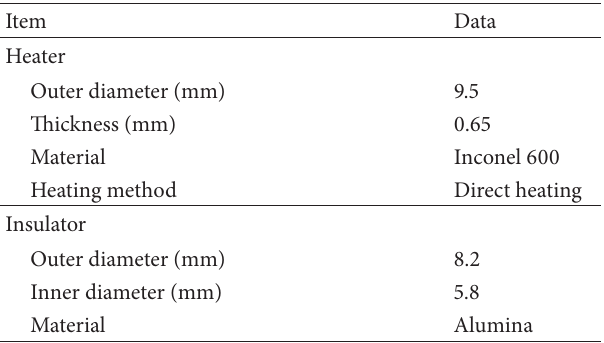
Table 8: Properties of heater rods.